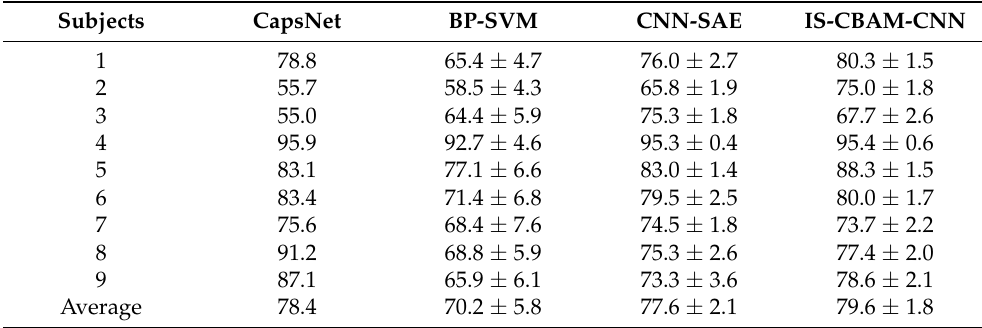
Table 1. Competition IV dataset 2b accuracy (%) results for CapsNet, BP-SVM, CNN-SAE and IS-CBAM-CNN.